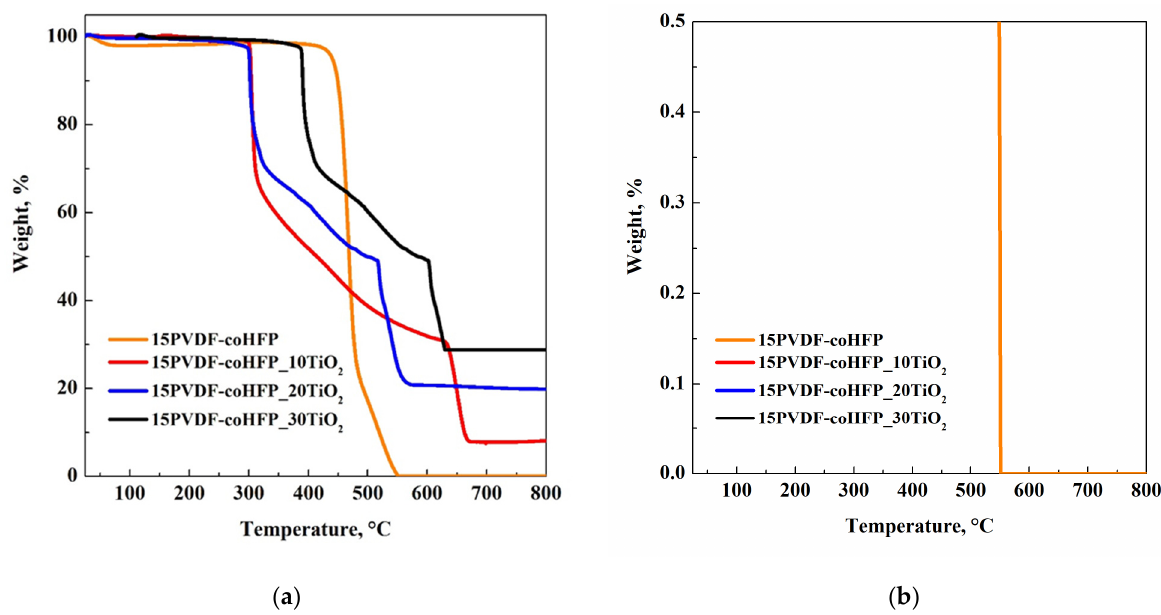
Figure 4. ( a ) TGA analyses of 15PVDF-coHFP (orange curve), 15PVDF-coHFP_10TiO 2 (red curve), 15PVDF-coHFP_20TiO 2 (blue curve), 15PVDF-coHFP_30TiO 2 (black curve); ( b ) enlargement of the orange curve in the range 0–0.5%. Table 2. Comparison between nominal and measured loading of TiO 2 in the polymeric membranes. Nominal Loading of TiO 2 [wt%]